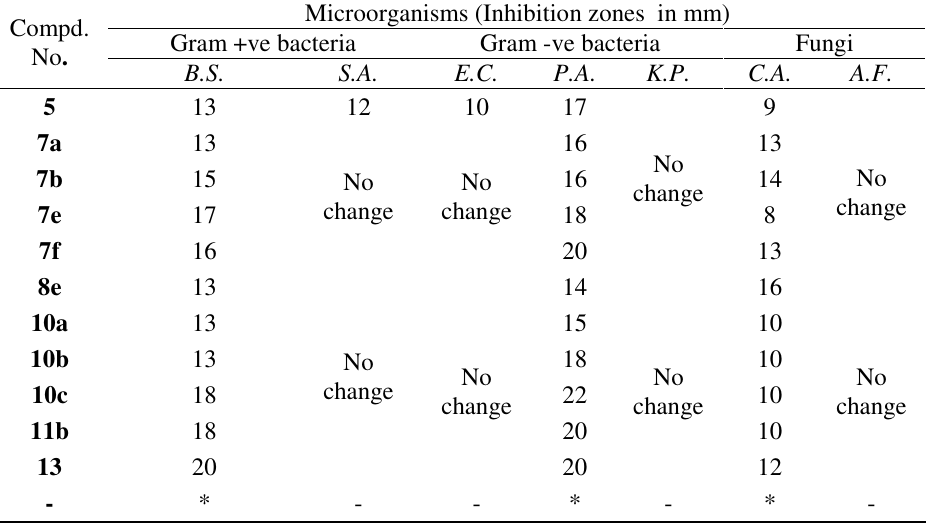
Table 4. Preliminary screening using UV (366 nm)